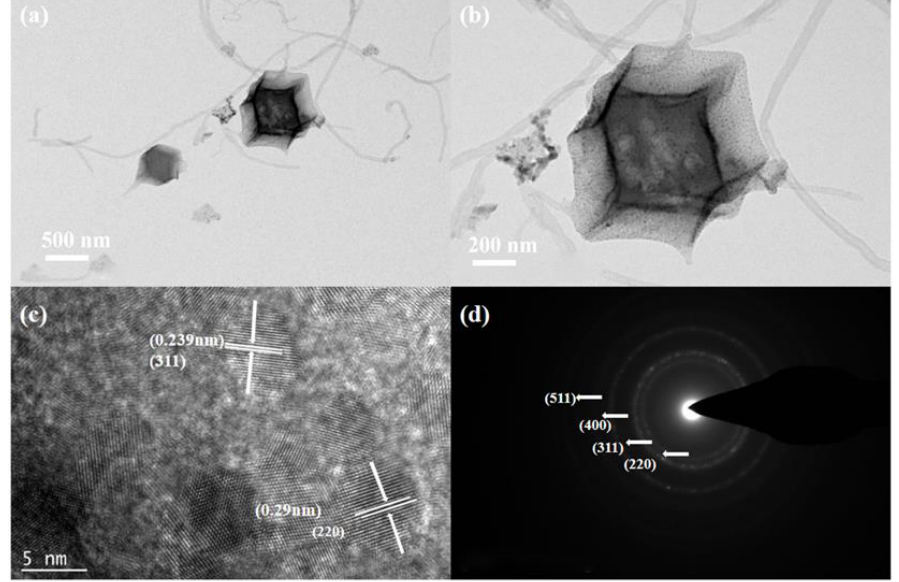
Figure 2. ( a , b ) TEM diagrams at different magnifications of MWCNT 3 @Co 3 O 4 ; ( c , d ) high-resolution transmission electron microscopy (HRTEM) and selected area electron diffraction (SAED) of MWCNT 3 @Co 3 O 4 .